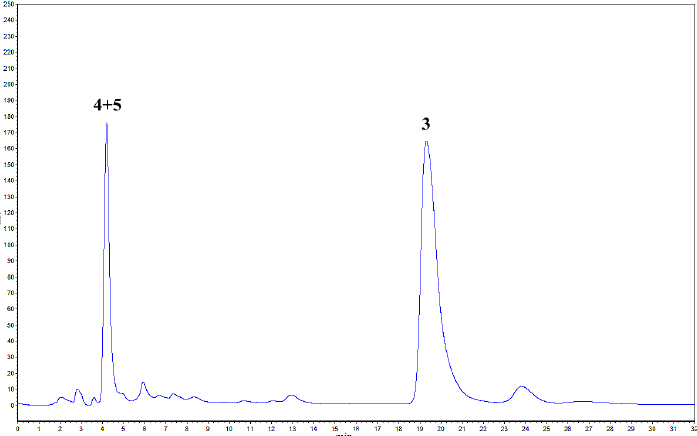
Figure 2 . Analysis of isorhapontigenin oxidation products by K 3 Fe(CN) 6 /NaOAc (32% CH 3 CN/H 2 O, λ = 230 nm, 1 mL/min).